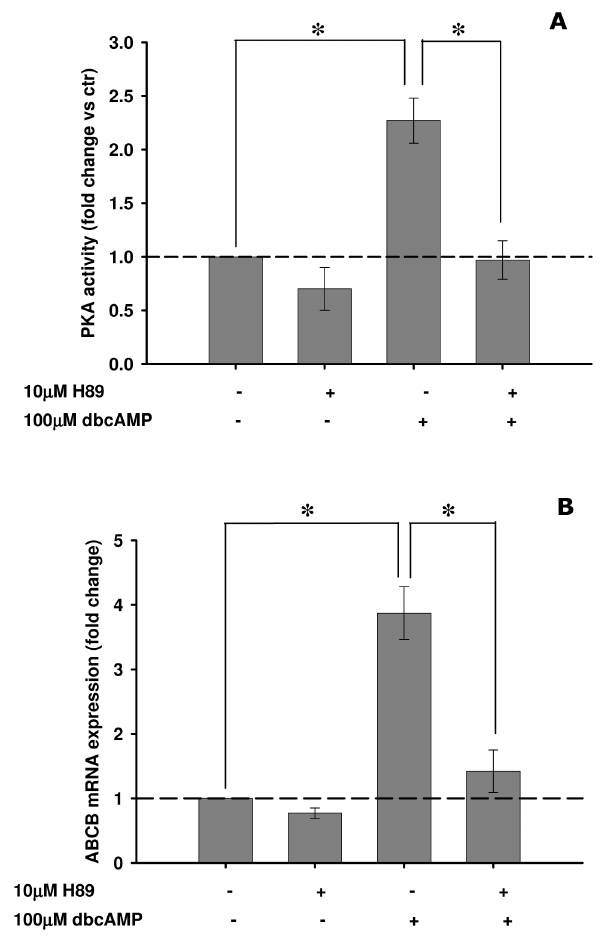
Figure 6. Effects of H89 pre-incubation on dbcAMP induced stimulation of PKA activity and ABCB mRNA expression in mussel haemocytes incubated invitro . (A) relative PKA activities; (B) relative ABCB mRNA expression. Both biological endpoints were assessed after 4 h of exposure to 100 m M dbcAMP in the presence/ absence of a 30-min pre-incubation with 10 m M H89. Data are derived from three independent experiments (mean 6 SEM); *p , 0.05 between pairs of samples. Basal PKA activity=1.12 6 0.17 nmol/min/mg